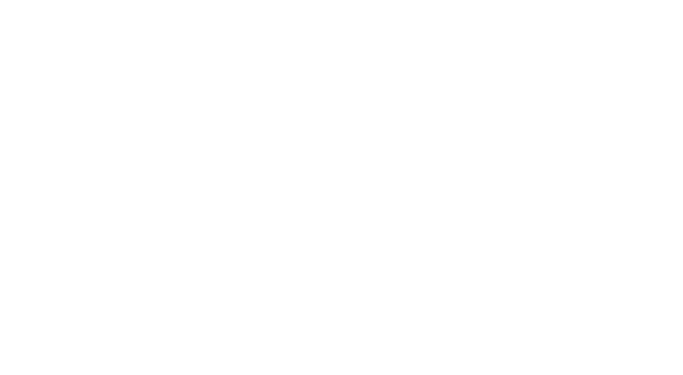
Fig. 2 The median NIHSS along the different periods in the total sample and in each group